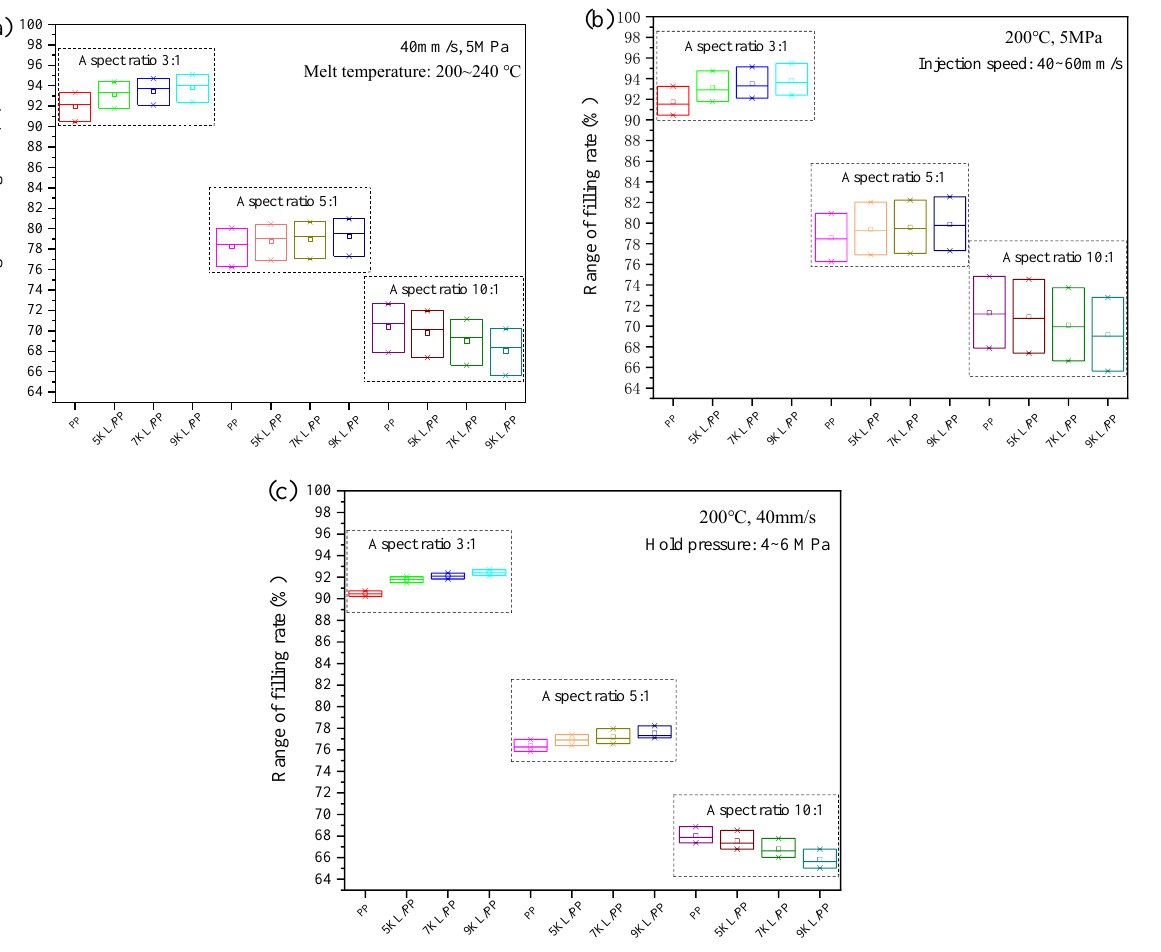
Figure 11. Effect of ( a ) melt temperature, ( b ) injection speed, and ( c ) hold pressure on the filling rate at different kaolin content and aspect ratios in the form of standard deviation.